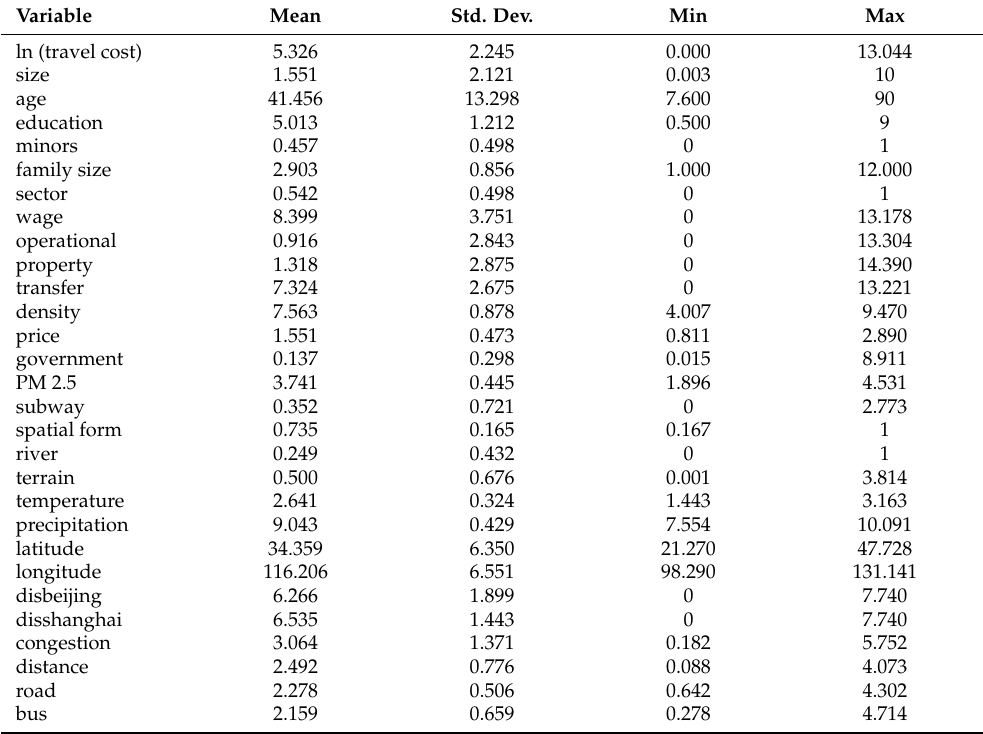
Table 1. Descriptive